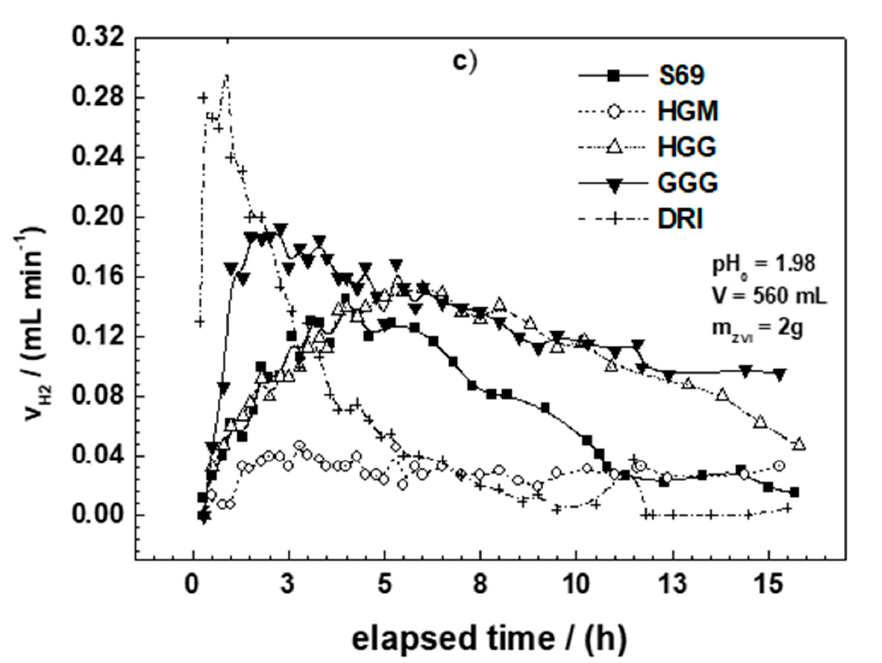
Figure 3. Rate of molecular hydrogen production (V H2 ) as a function of time for the Fe 0 materials tested in this work: ( a ) ST1, ST2, and S69; ( b ) model mild steels (C15, C45, C60, C100) and scrap irons (S15, S69); ( c ) commercial Fe 0 (GGG, HGG, HGM, DRI) and S69. The experiments were conducted at 22 ± 2 ◦ C. ZVI stands for Fe 0 . The represented lines are not fitting functions, but they just connect points to ease